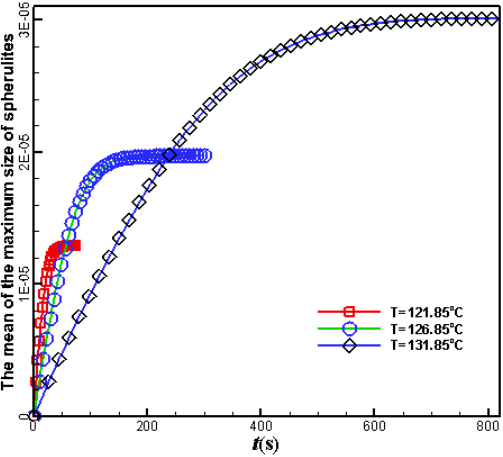
Figure 8. The mean of the maximum size of spherulites versus time under different temperatures.